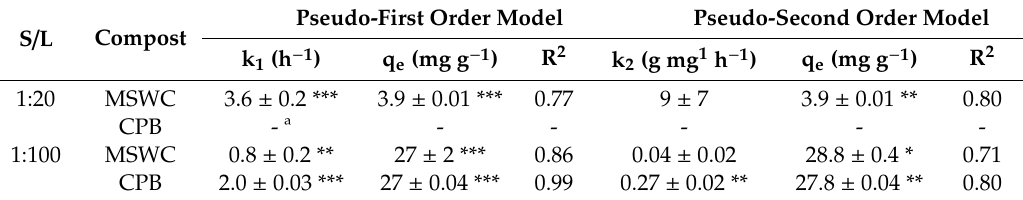
Table 2. Kinetic model parameters (estimation ± standard error). MSWC: municipal solid waste compost; CPB: composted pine bark. S/L: solid/liquid ratio; k 1 : pseudo first-order kinetic rate; k 2 : pseudo second-order kinetic rate; R 2 : correlation coefficient between experimental and modeled data.